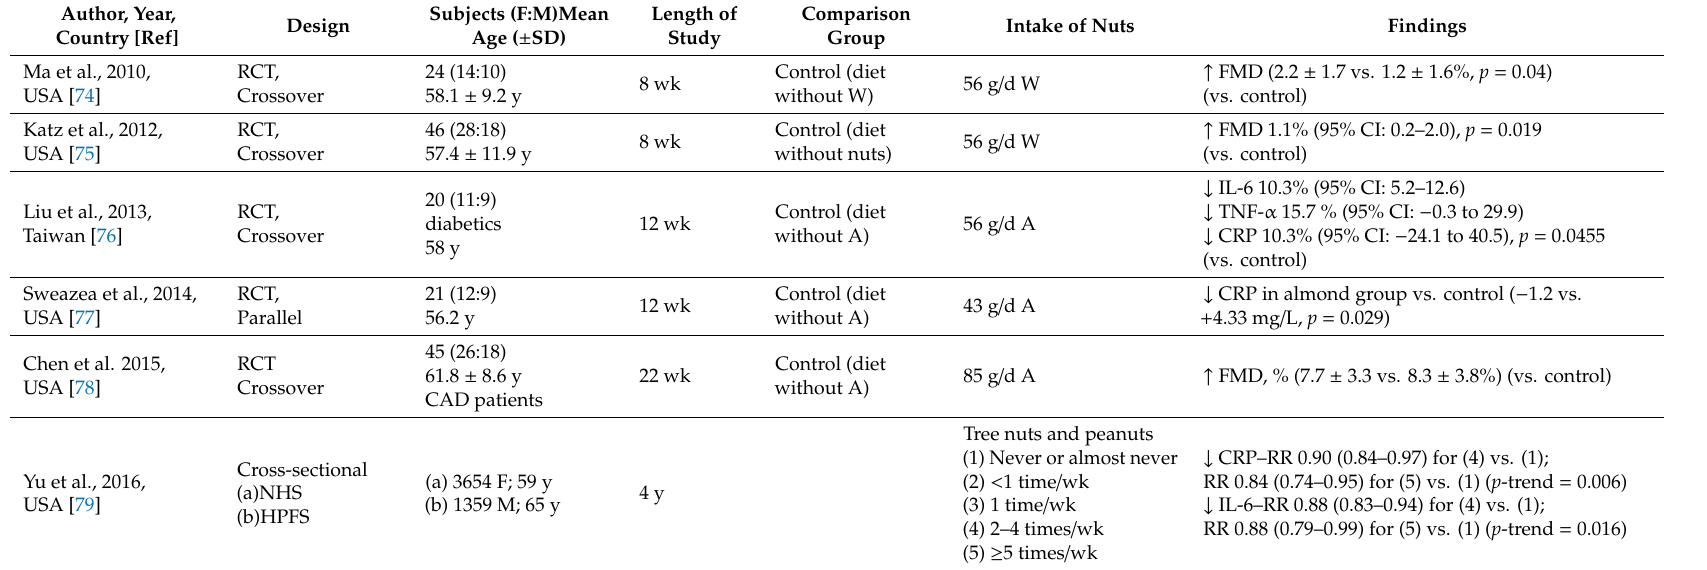
Table 4. Nut consumption and endothelial function and inflammatory